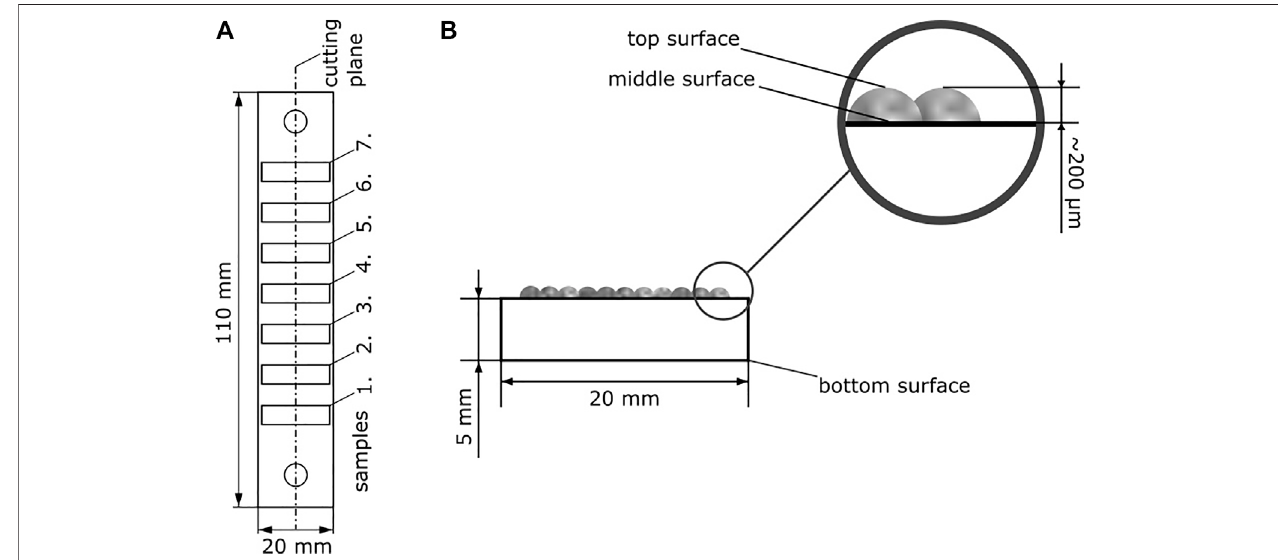
FIGURE 1 | Top view (A) and front view (B) of the baseplate.